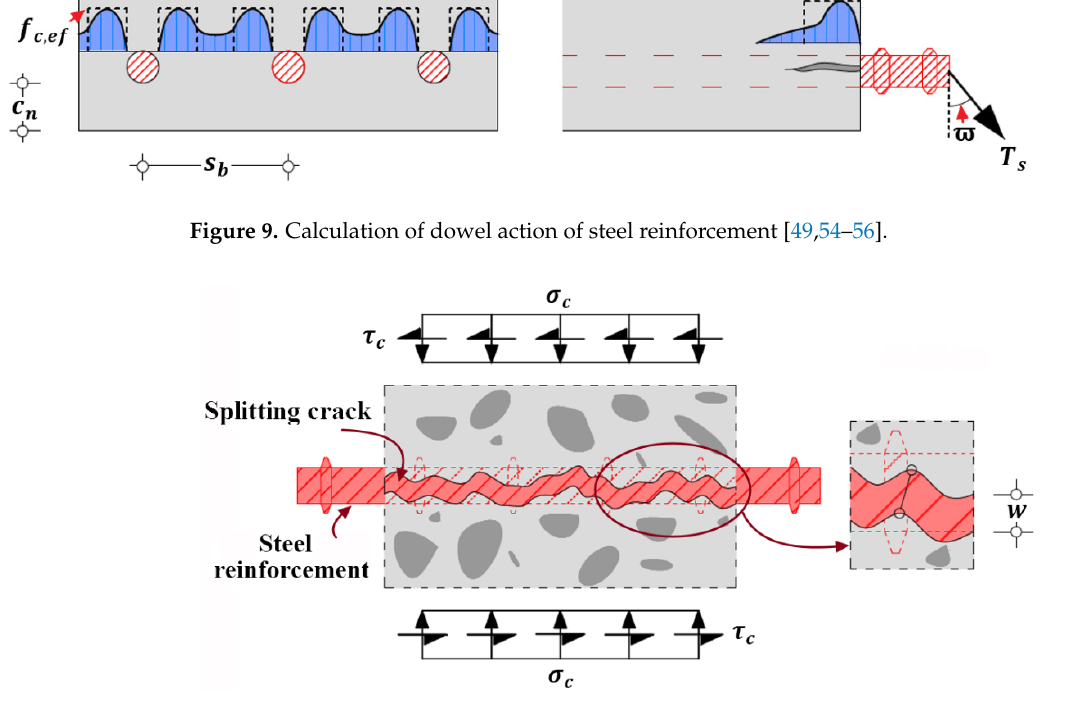
Figure 10. Details of cracked concrete with splitting crack.